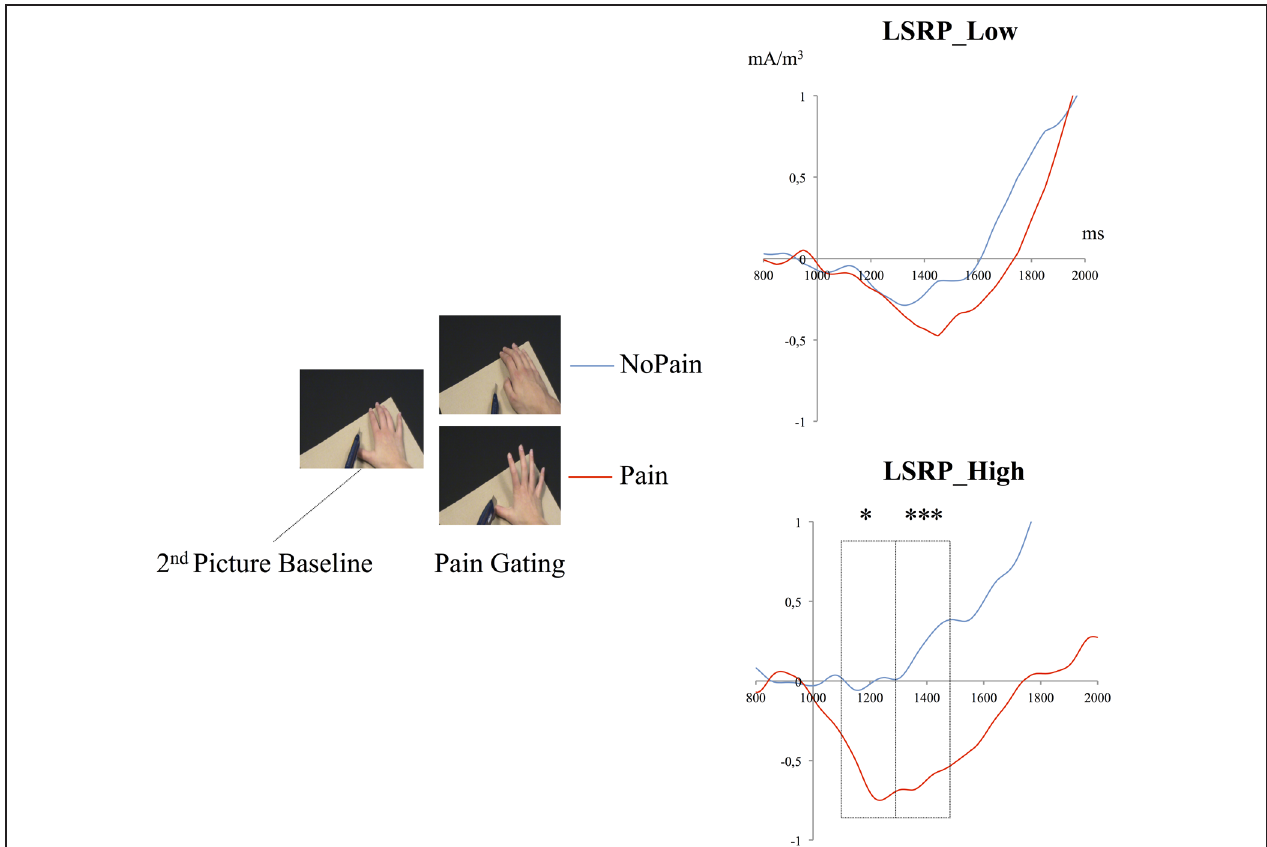
FIGURE 5 | Time course of the mean energy (mA/m 3 ) of the SG during the presentation of the third picture (i.e., the picture where the painful contact occurred or not). The mean energy ratios during the